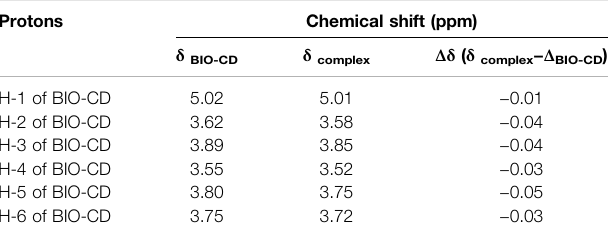
TABLE 2 | The water solubility of AD-CBD and its inclusion complex in buffer solution (KH 2 PO 4 /K 2 HPO 4 , pH 7.0, 25 ° C).